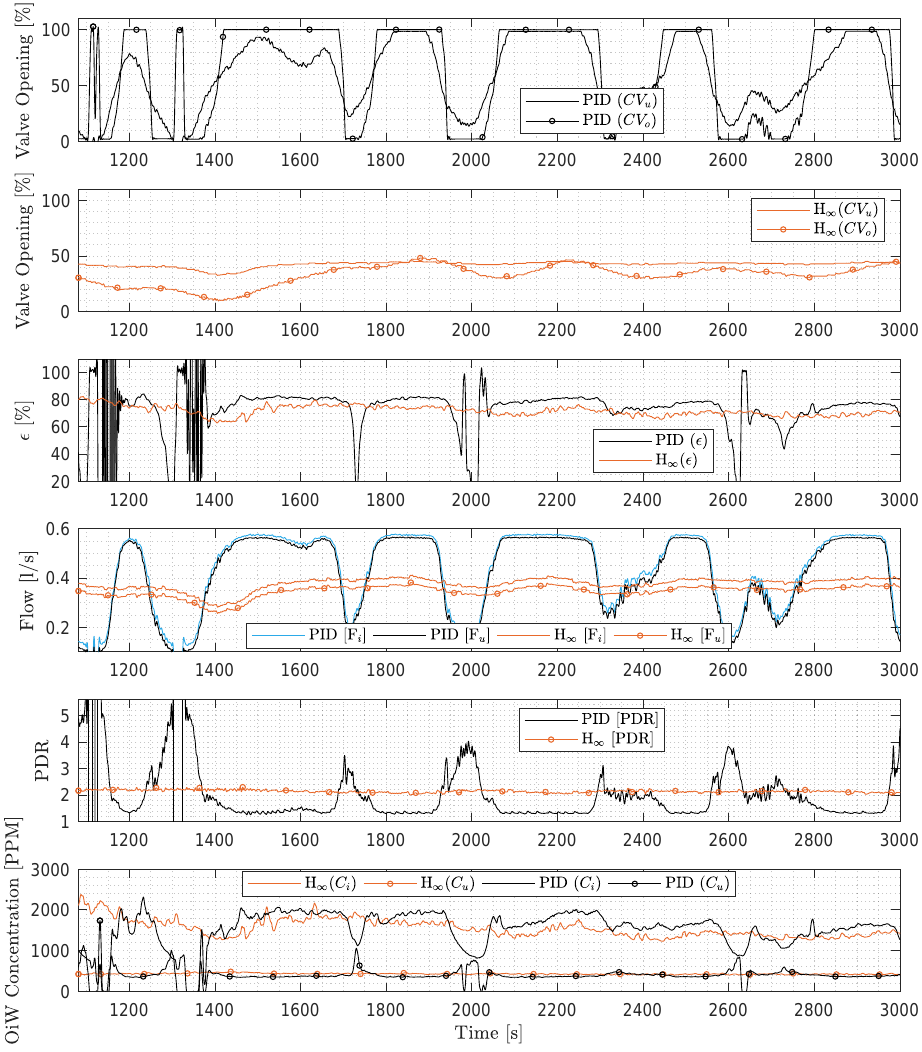
Figure 4. Experiment Results: controller evaluation with fluctuating inlet flow rate F i . The plots show valve openings, efficiencies, flows, PDRs, and OiW